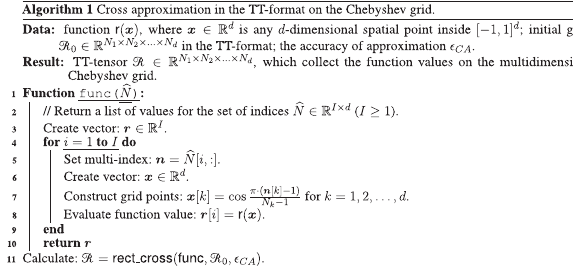
Algorithm 1 the description of the process of